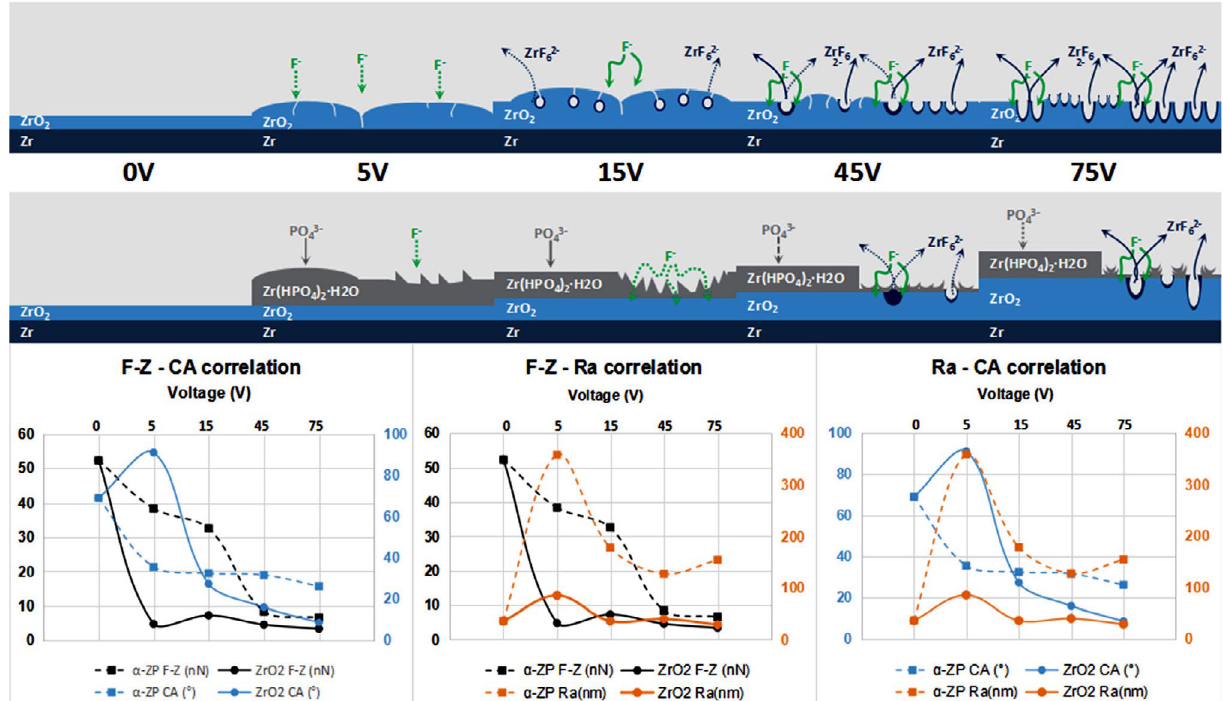
Fig. 7 Proposed film forming mechanism for α-ZP and ZrO 2 and correlation of analyzed surface